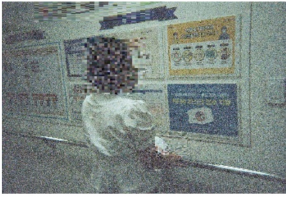
Figure 11. The back of a social